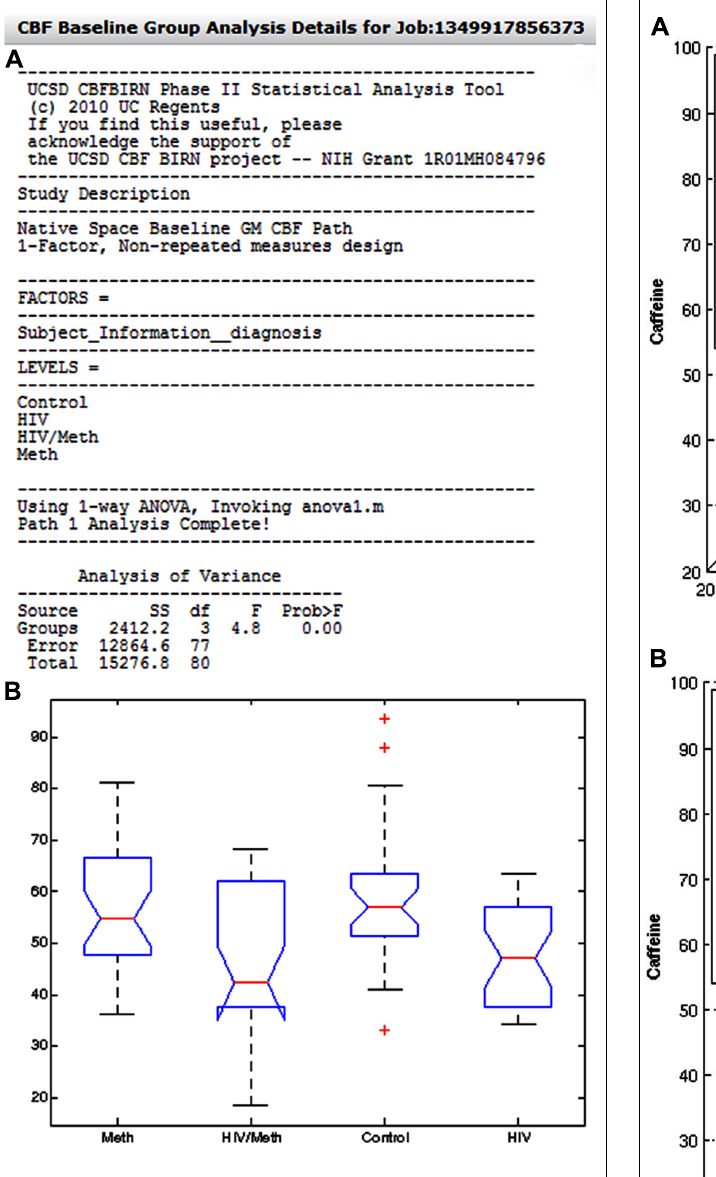
FIGURE 12 | (A) The system-generated group analysis report from an example study, looking at the effect of HIV and methamphetamine use on whole-brain gray matter CBF. Also shown in the report is a box plot (B) summarizing the range and mean of gray matter CBF values across factor levels.